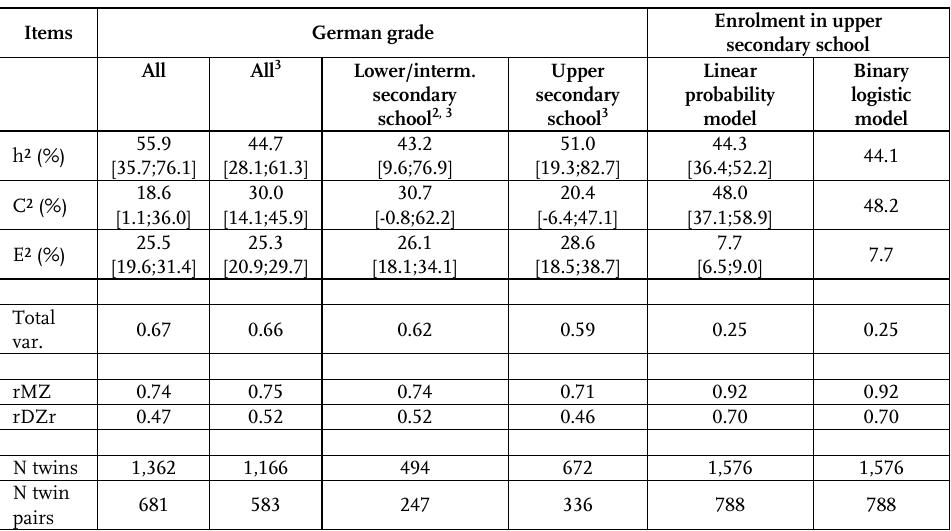
Table 5 : Results of multilevel mixed-effects ACE variance decomposition models, confidence intervals in brackets 1